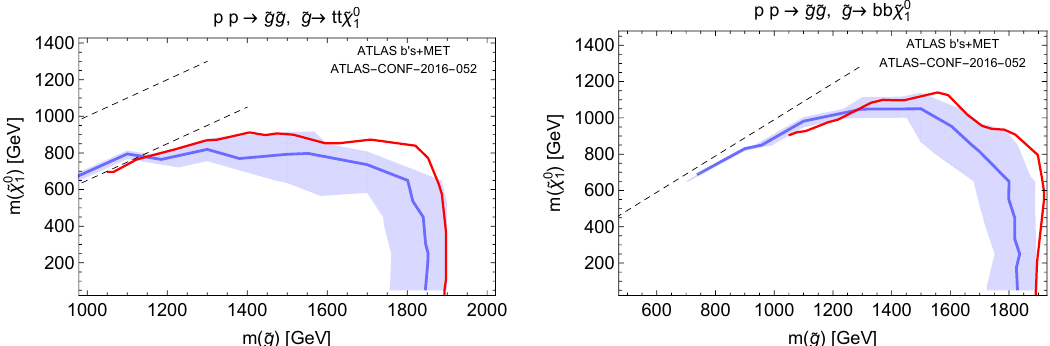
Figure 10 . Limits on supersymmetric simpli(cid:12)ed models from our recasted search of [31] (blue lines) with 50% error on the number of events in the signal regions (blue shaded regions), compared to the experimental results (red